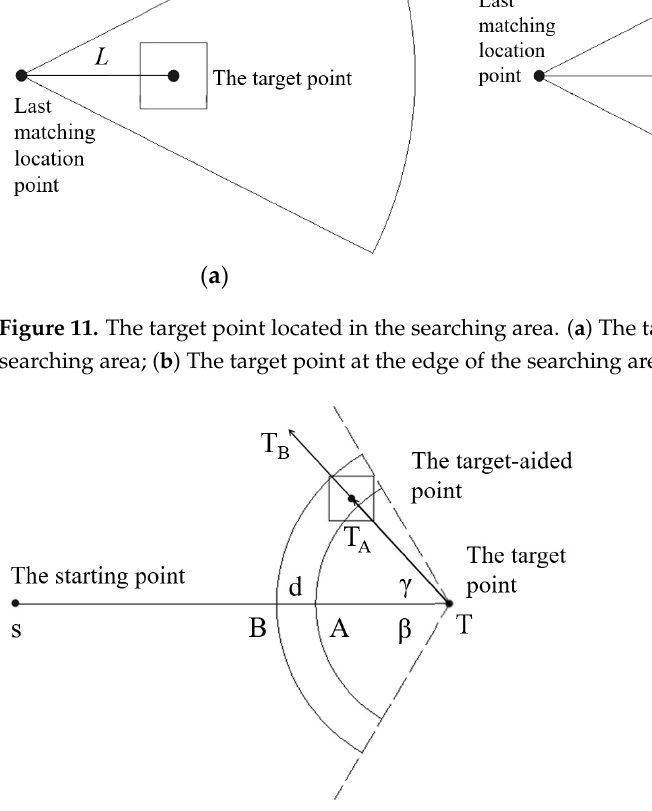
T . Figure 12. The setting of target aided point T A A